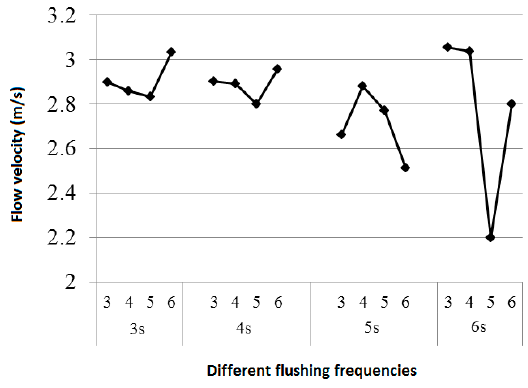
Figure 11. Flow velocity comparison of all frequencies (round nozzle at the bottom of the pipe).